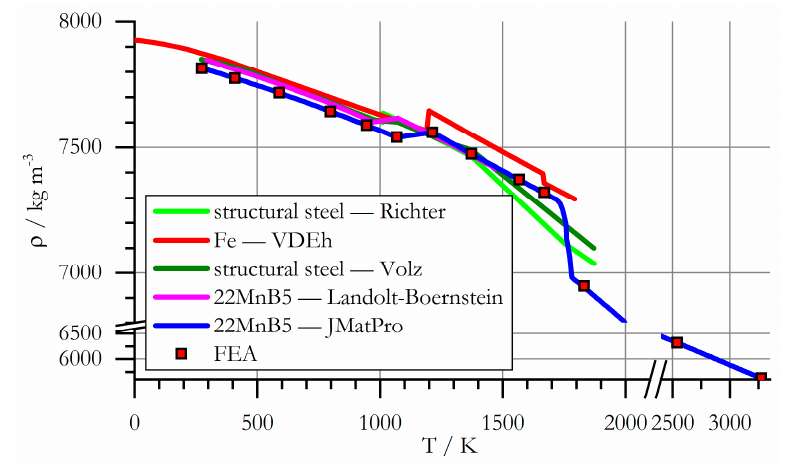
Figure 10. Mass density of 22MnB5.